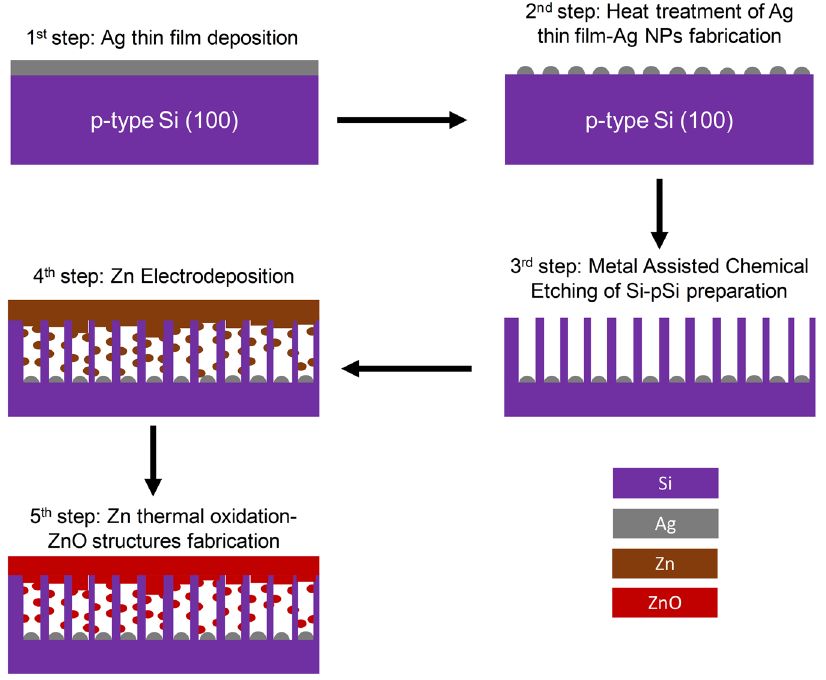
Figure 1. Schematic of the presented process for the production of pSi/ZnO NS emitting broadband light in the visible